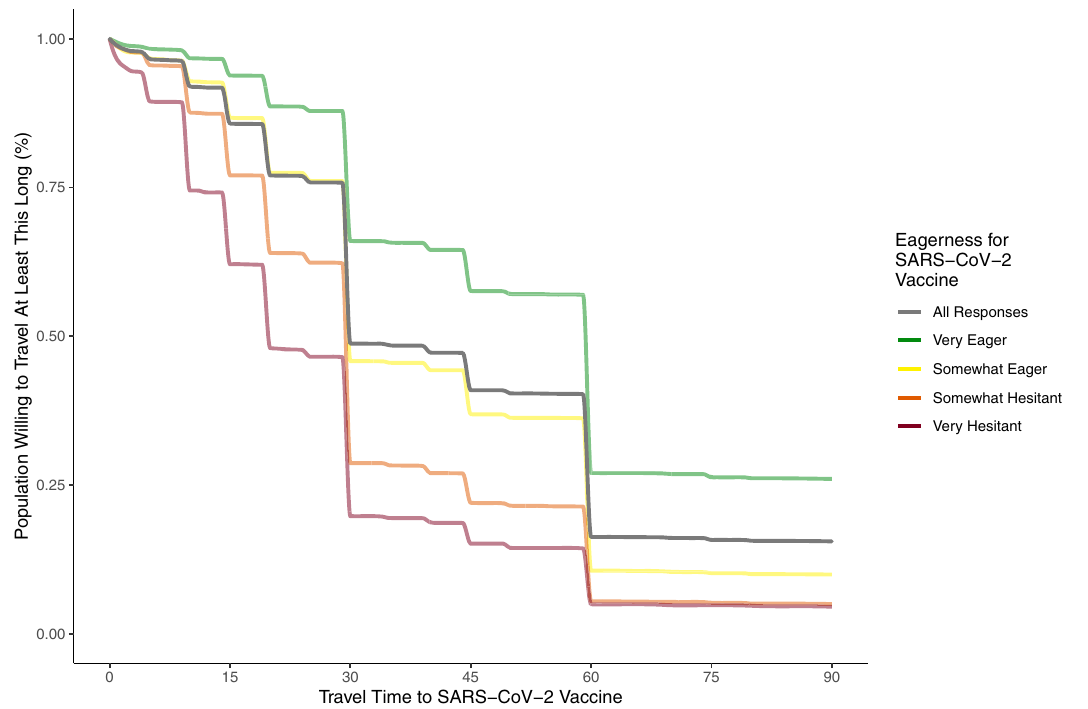
Fig. 2 Population willingness to travel to COVID-19 vaccine by vaccine hesitancy. Responses ( N = 23,288) to OutbreaksNearMe U.S. national web survey on how long people were willing to travel for the COVID-19 vaccine strati fi ed by self-reported vaccine hesitancy. Lines are monotonic cubic splines fi t to 1 minus the empirical cumulative distribution of these response times. Responses were limited to individuals considering a vaccine, de fi ned as those who reported either “ yes ” or “ not sure ” when asked if they would get the vaccine.